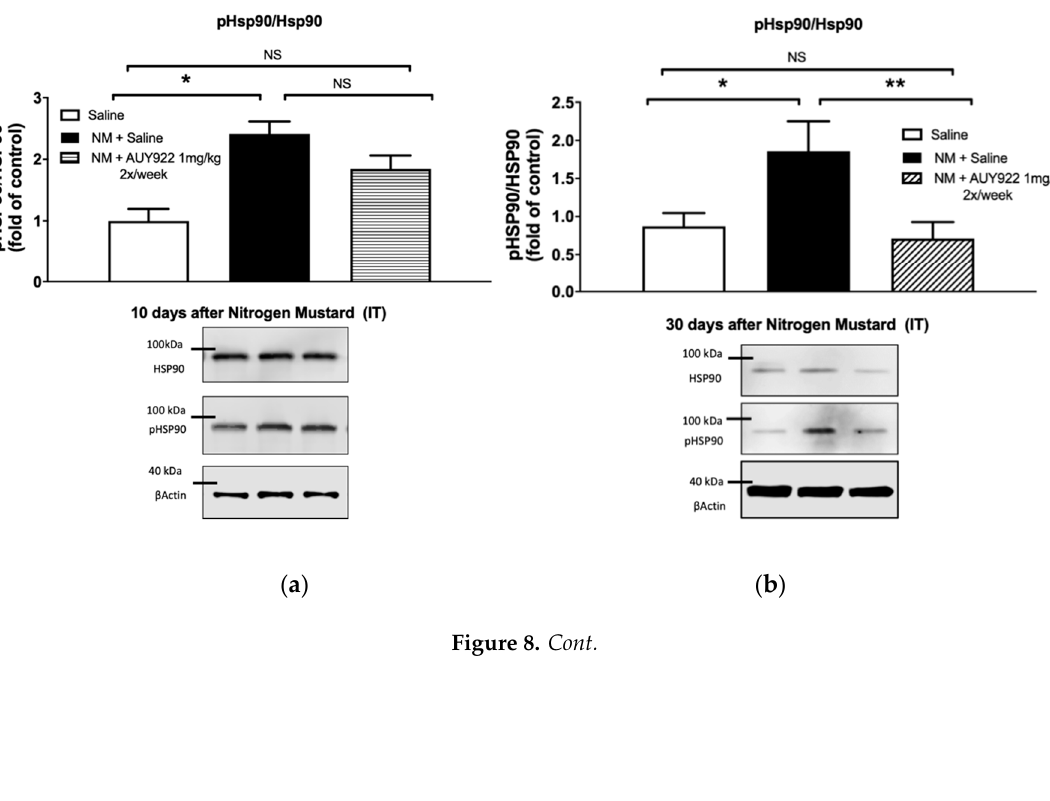
Figure 7. The HSP90 inhibitor, AUY-922, blocks the NM-induced increase in ERK activation (ERK phosphorylation, p-ERK) in mouse lung homogenates, analyzed by Western blotting. Mice received 0.625 mg/kg NM or saline (2 μ L/g body weight, intratracheally) on day 0. They then received AUY-922 (1 mg/kg, 2×/week or 2 mg/kg 3×/week intraperitoneally) for 10 ( a ) or 30 ( b , c ) days, starting 24 h after NM. Protein quantification is expressed as fold of control mice. Means ± SEM; n = 4 mice per group; *: p < 0.05, **: p < 0.01, NS: not significant with ANOVA and Turkey’s.